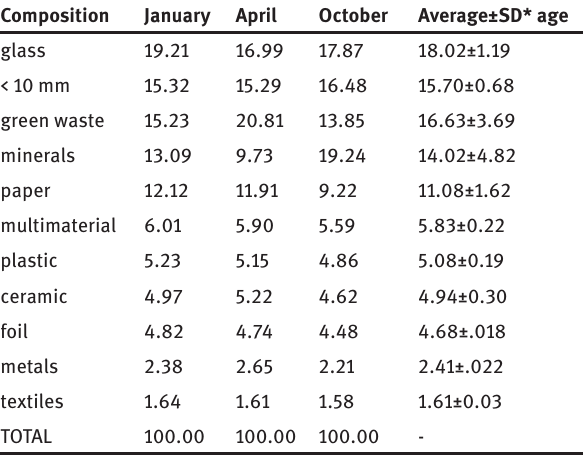
Table 1: The composition of the 0-80 mm waste directed to the